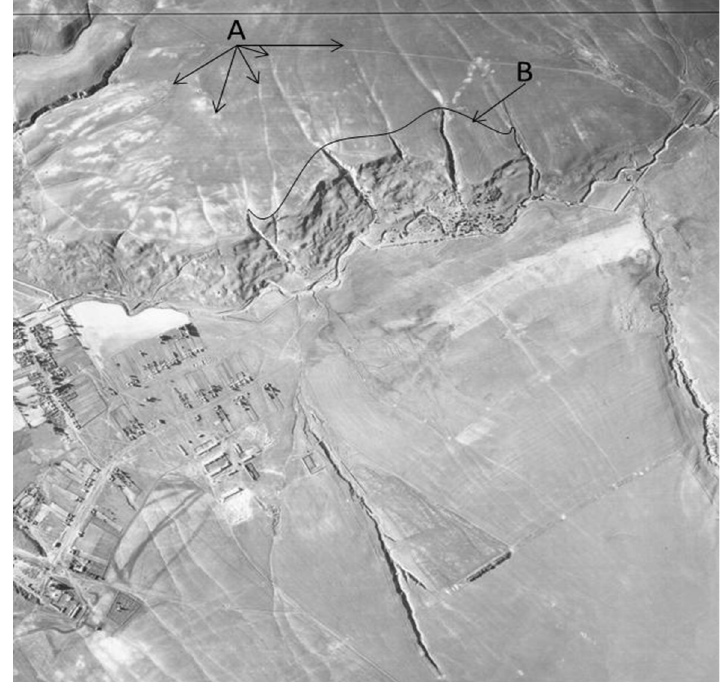
Figure 1. The allocation of erosion belts using interpretation aerial photographs. A is the detection of the lower boundary of the sheet and rill erosion at the tops of stream erosion; B is the boundary of the gully erosion belt changed by landslide processes (aerial photograph fragment; scale 1:17,000).